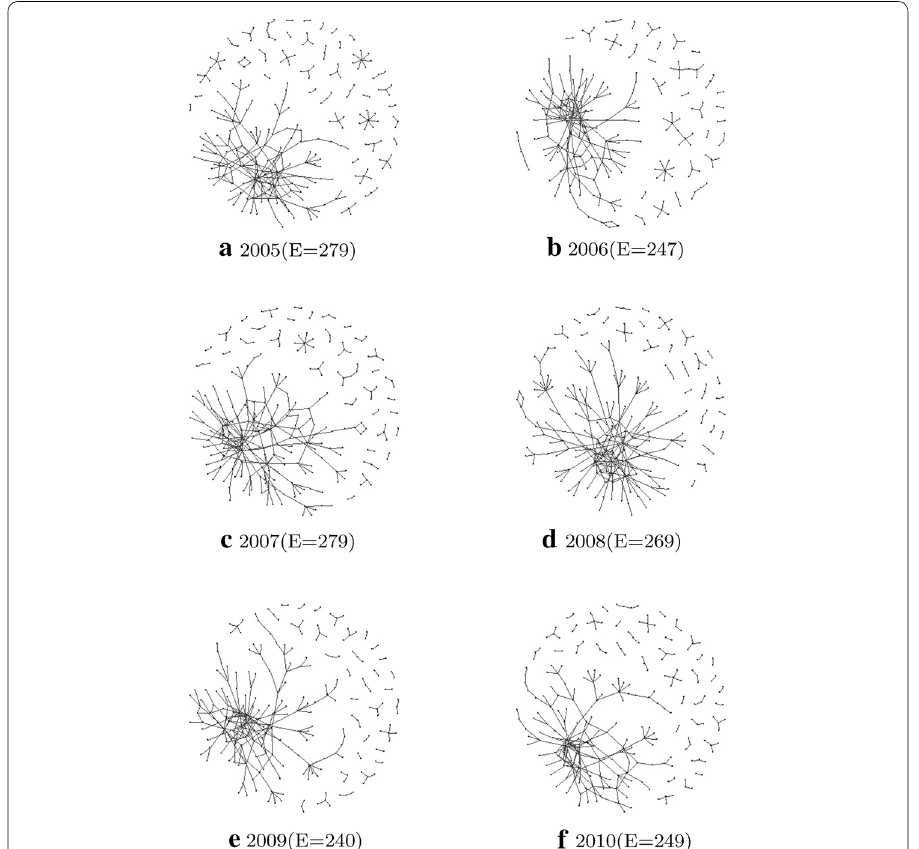
Fig. 7 Changes in B2B networks over time. The networks comprises the core and peripheral structures and show that the edges are aggregated toward the centers of the networks. There are also peripheral-networks around the